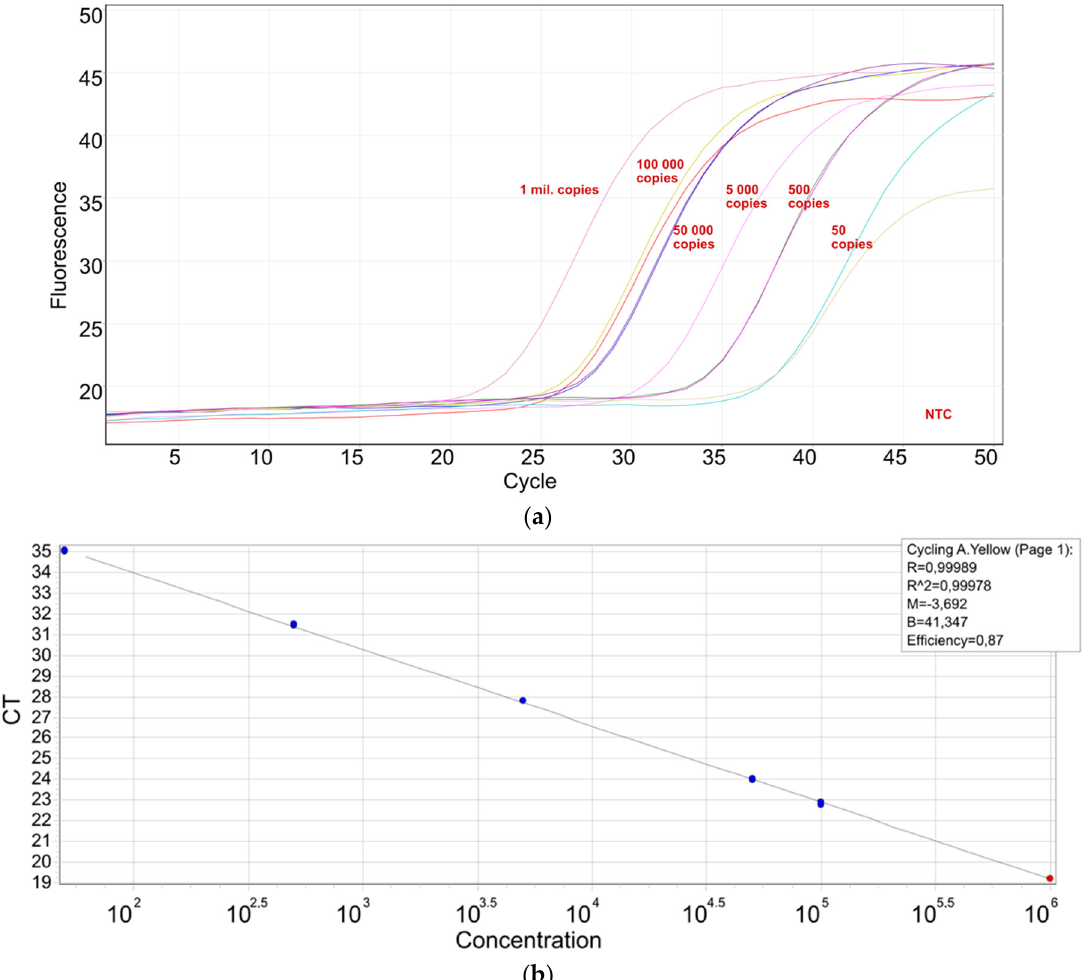
Figure 5. A real-time PCR system for StrVA detection: ( a ) a synthetic standard was used to assess the sensitivity of the real-time PCR used for the detection of StrVA; ( b ) standard curve parameters.